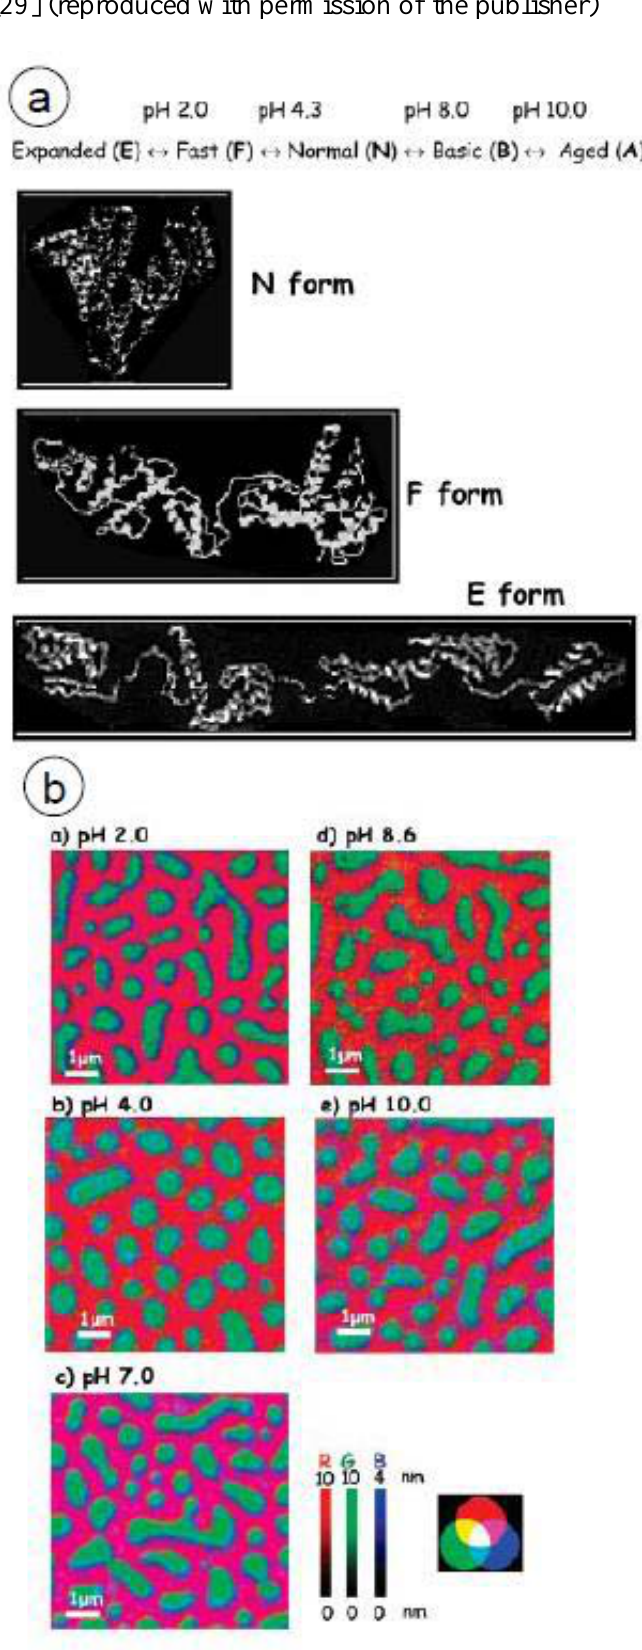
Figure 5 . (a) Conformation of HSA at various pH and (b) Rescaled color coded images of HSA adsorbed to PS/PMMA at the C 1s edge at five different pH. PS = red, PMMA = green and HSA = blue. [29] (reproduced with permission of the